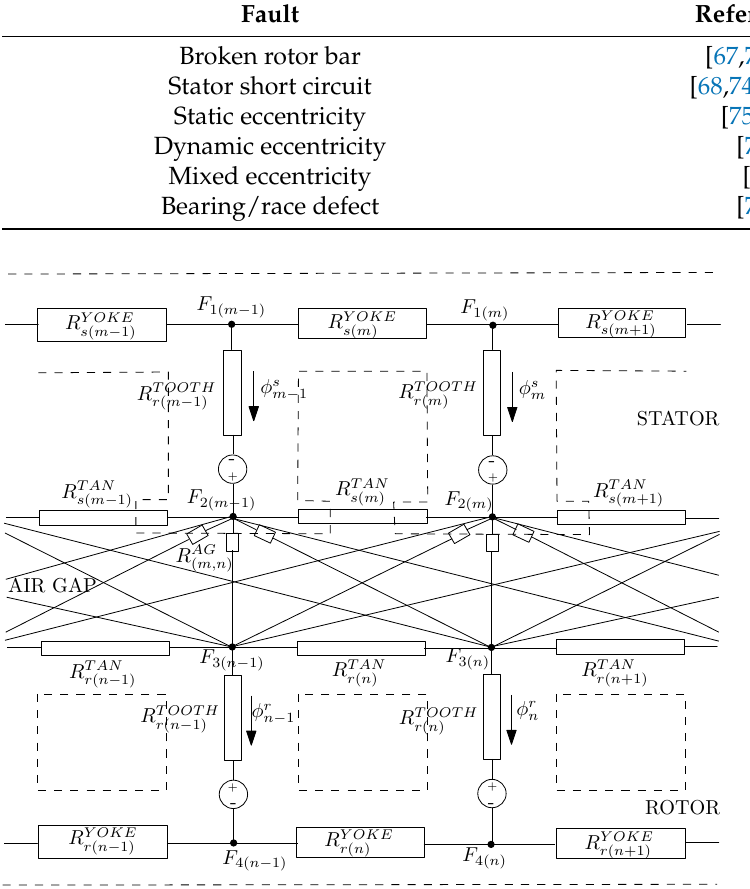
Figure 5. Simplified magnetic equivalent topology for healthy IM with closed rotor slot